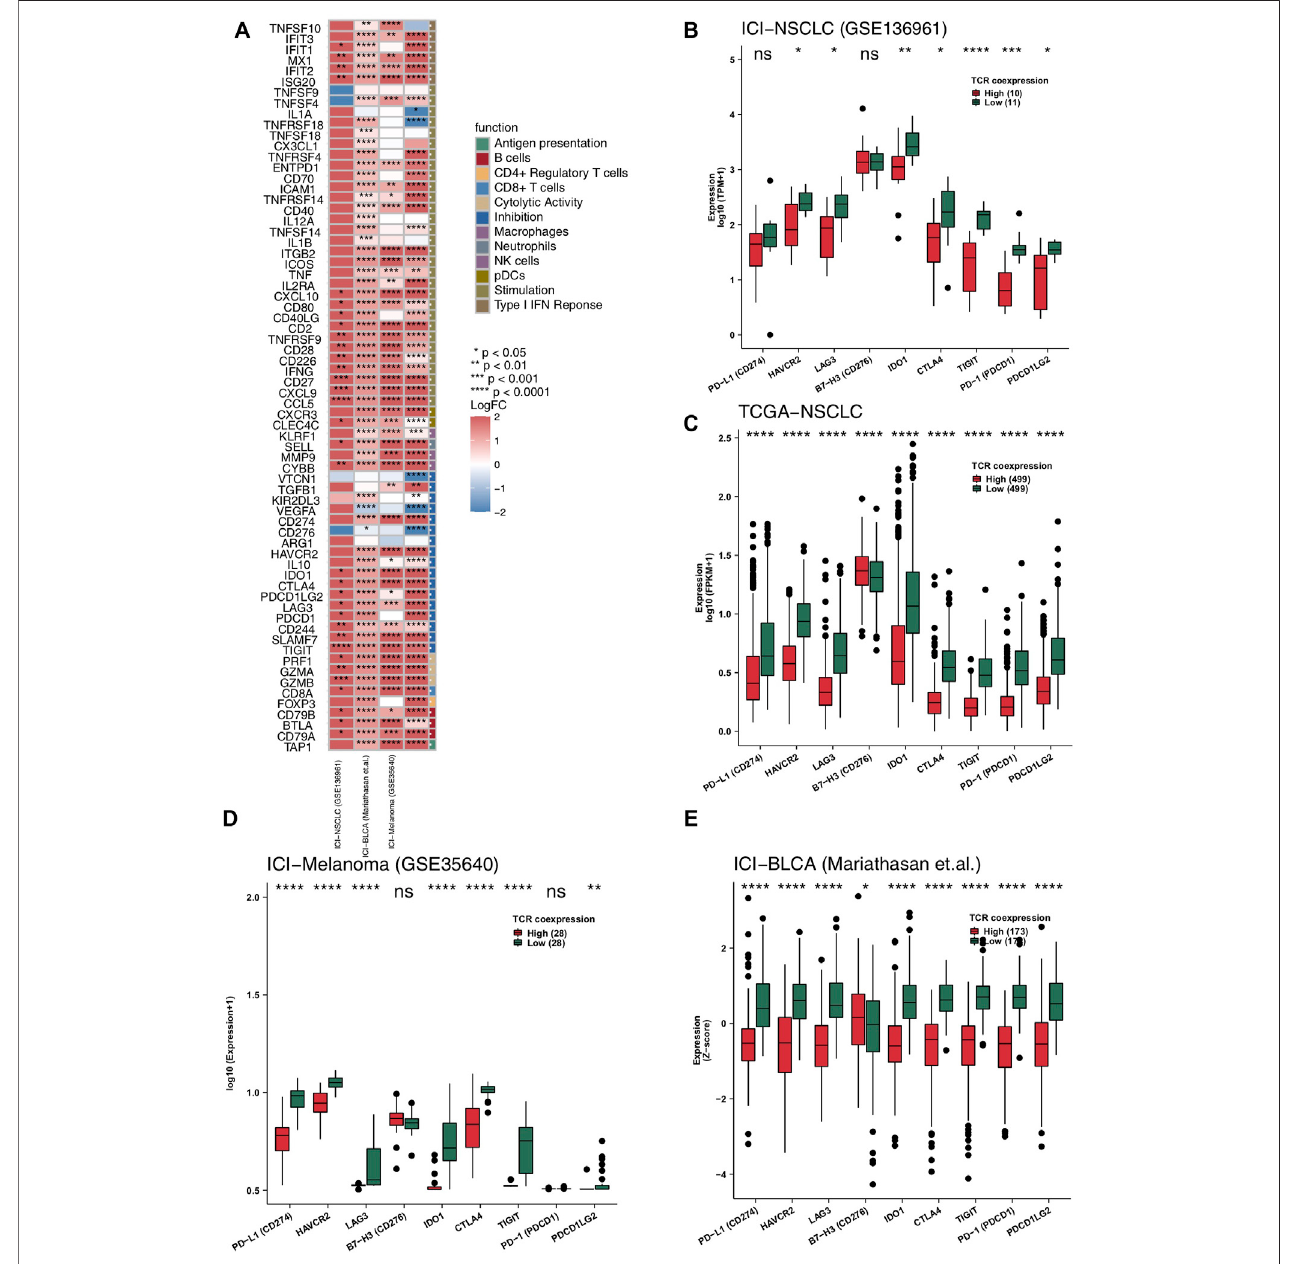
FIGURE 4 | High TCR coexpression signature was associated with high expression levels of immune-related genes. (A) Comparison of the expression levels of immune-related genes between the high- and low- TCR coexpression signature groups. Heat map depicting the mean differences in immune-related gene mRNA expression between high- and low- TCR coexpression signature groups across different cohorts. The x -axis of the heat map indicates different cohorts, and the y -axis indicatesgenenames.Eachsquarerepresentsthefoldchangeordifferenceofeachindicatedimmune-relatedgenebetweenthehigh-andlow-TCRcoexpression signature groups in each cohort. Red indicates up-regulation and blue indicates down-regulation. Box plots comparing the expression levels of immune checkpoint molecules between the high- and low- TCR coexpression signature groups from the ICI-NSCLC (B) , TCGA-NSCLC (C) , ICI-Melanoma (GSE35640) (D) , and ICI-BLCA (Mariathasan et al.) (E) cohorts. The range of p-values is presented by the asterisks above each box plot (* p < 0.05; ** p < 0.01; *** p < 0.001; **** p < 0.0001; Mann- Whitney U test).